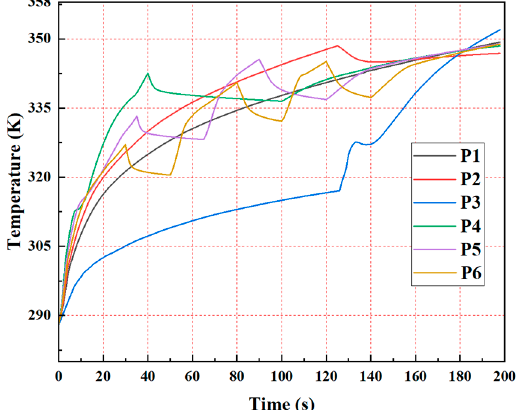
Figure 17. Evolutions of the hydrogen temperature rise for Cylinder B at di ff erent pressure rise pat- terns.